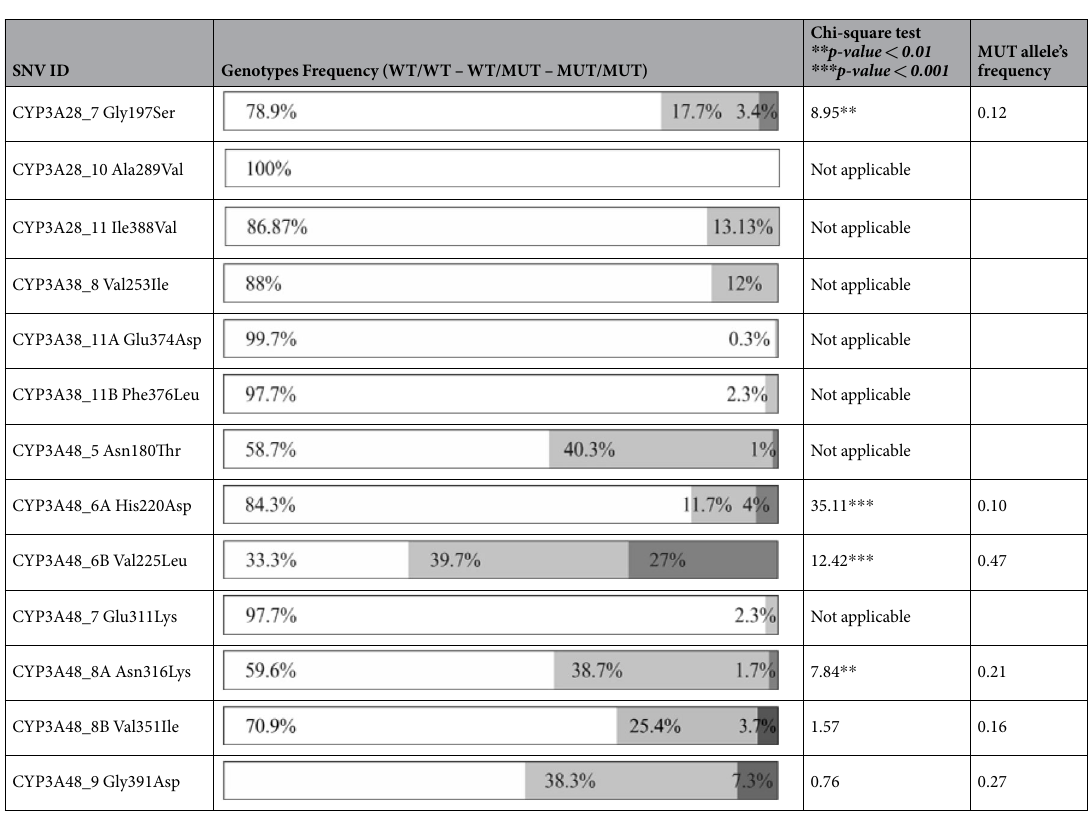
Table 2. Genotypes and mutant alleles frequency of b CYP3A SNVs in the Piedmontese cattle cohort. Hardy- Weinberg Equilibrium (HWE) was assessed by means of Chi-square test. Asterisks highlight significant deviations from HWE. WT/WT, WT/MUT and MUT/MUT genotypes frequency are represented by white, light and darker gray bars,